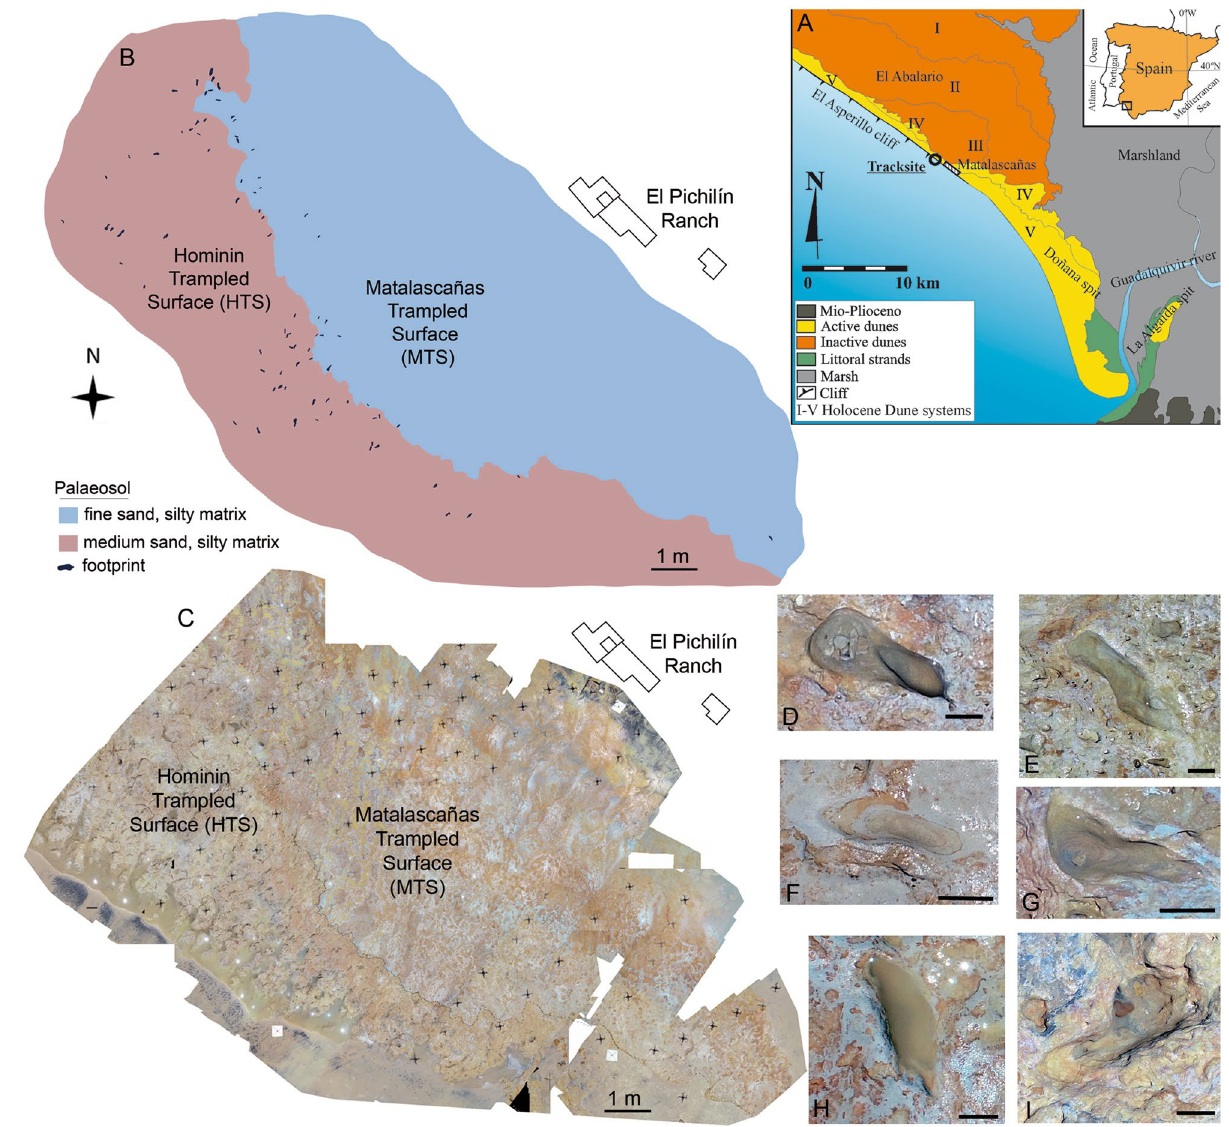
Figure 1. The Matalascañas site (El Pichilín Ranch area). ( A ) Geographical location and geological setting. ( B ) Mapping for the hominin footprints (HTS) and animal tracks (MTS) A and B from 6 . ( C ) Aerial view of the drone flight. ( D – I ) Some relevant footprints from the outcrop. All scale bar: 5 cm. ( D ) M2020-02. ( E ) M2020-06. ( F ) M2020-05. ( G ) M2020-11. ( H ) M2020-74. ( I ) M2020-35. The map in ( B ) was created using Adobe Photoshop Versión: 9.0 (https:// adobe- photo shop-9- cs2. en. lo4d. com/) based on the photogrammetric orthomosaic ( C ) produced using Pix4DMapper© (versión PIX 4D Cloud, https:// www. pix4d. com/). ( C ) was obtained by a low-altitude programmed flight using an Unmanned Aerial Vehicle (UAV) on June the 6th, 2020, 12 AM UTC. A multirotor DJI Phantom 4 + with a 4 k 20 Mpix RGB CMOS camera was collected at an average height of 7 m above the ground photographs over the study area (564 m 2